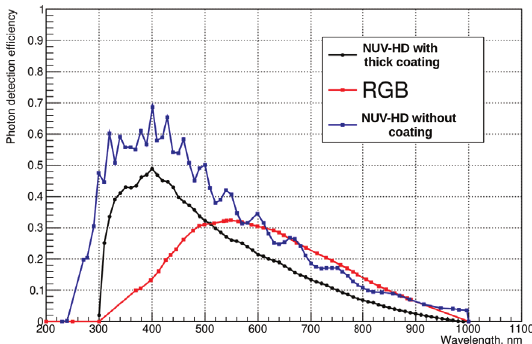
Figure 10: Photon detection e ffi ciency versus photon wave- length for di ff erent SiPM types by